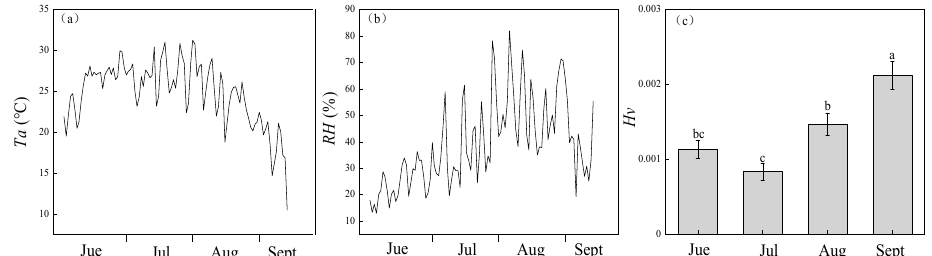
Figure 2. ( a ) Variability in daily mean temperature (T a , °C) and ( b ) daily mean relative humidity (RH, %), and ( c ) seasonal change in Huber value (HV). Lower-case letters denote significance levels from Analysis of variance (ANOVA) based on post hoc means using least significant difference test (LSD) analysis ( p < 0.05). Data in (c) are means with standard error.